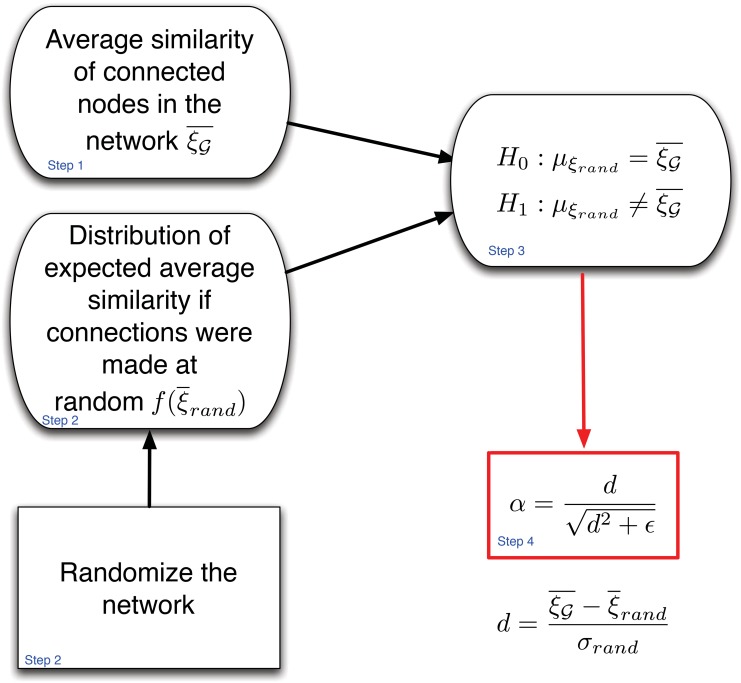
The computation of VA-index in a nutshell.
VA-index involves network randomization and empirical hypothesis testing for quantifying the assortativity of a network with respect to a mutli-dimensional nodal attribute.